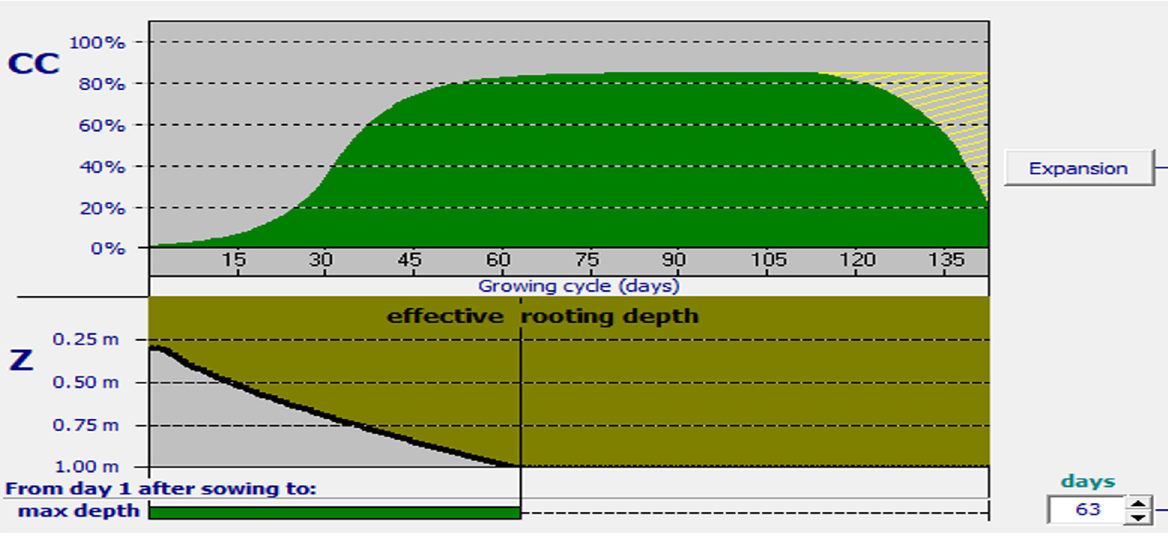
Figure 2: E ff ective root depth of wheat varieties by the Aquacrop